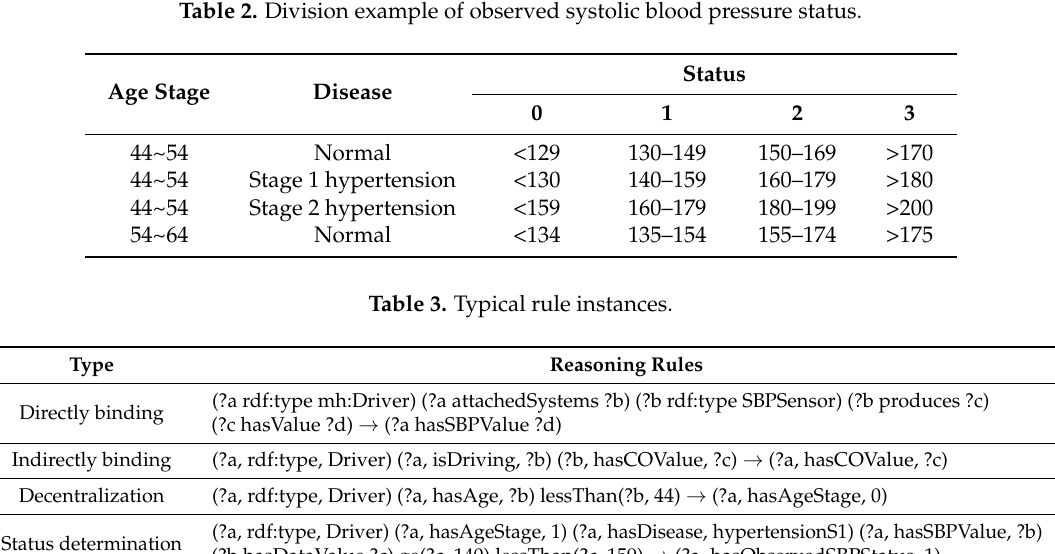
Table 2. Division example of observed systolic blood pressure status.